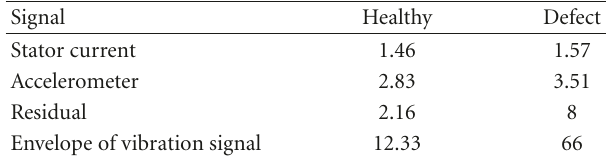
Table 2: Kurtosis